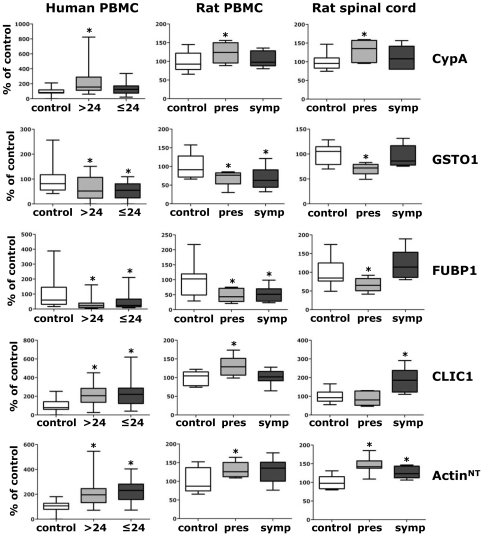
Analysis of protein biomarkers in the G93A SOD1 transgenic rat model: comparison with sALS patients.Human PBMC (left column): box-plot shows relative immunoreactivity for the indicated proteins measured by dot blot assay in ALS>24 (n = 30) (grey box) and ALS≤24 (n = 30) (dark grey box) patients as percentage of healthy controls (control) (n = 30) (white box). *, significantly different (p<0.05) from control (univariate logistic regression). Rat PBMC (middle column): box-plot shows relative immunoreactivity for the indicated proteins measured by WB (except for actinNT, measured by dot blot) in PBMC lysates (15 µg) of presymptomatic (pres) (n = 6) and symptomatic (symp) G93A SOD1 (n = 6) rats as percentage of non transgenic (control) (n = 8) rats. Protein level values were normalized to actin loading control. *, significantly different (p<0.05) from controls (one-way ANOVA followed by Newman-Keuls multiple comparison test). Rat spinal cord (right column): box-plot shows relative immunoreactivity for the indicated proteins measured by dot blot in ventral horn tissue lysates of presymptomatic (pres) (n = 6) and (symp) G93A SOD1 (n = 6) rats as percentage of non transgenic (control) (n = 8) rats. Immunoreactivity was normalized to the actual amount of protein loaded, detected after Red Ponceau staining. *, significantly different (p<0.05) from control (one-way ANOVA followed by Newman-Keuls multiple comparison test).